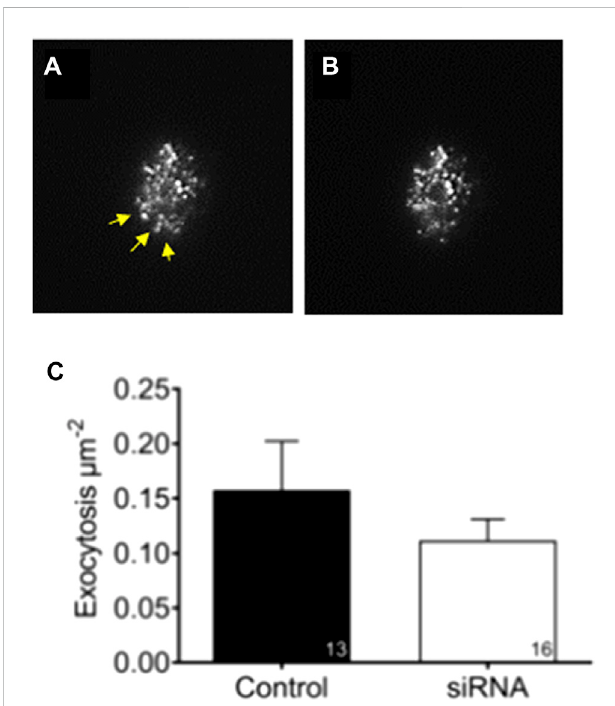
FIGURE 6 Knockdown of aSyn have no effect on glucose stimulated exocytosis. To study if knockdown of aSyn changes the exocytosis rate at a single granule level, EndoC- β H1 cells were transfected with aSyn siRNA before being infected with adenovirus coding for NPY- tdmOrange2 granule marker. Images were captured prior to and during glucose stimulation using TIRF microscopy. (A) An image captured prior to secretion and yellow arrowheads points to the region of interest. (B) An imagecaptured during glucose stimulation shows that granuleswere released (C) The exocytosis rate between siRNA treated group (0.158 ± 0.045) and the control group (0.112 ± 0.019) was comparable. Student ’ s t-test, mean ± SD.